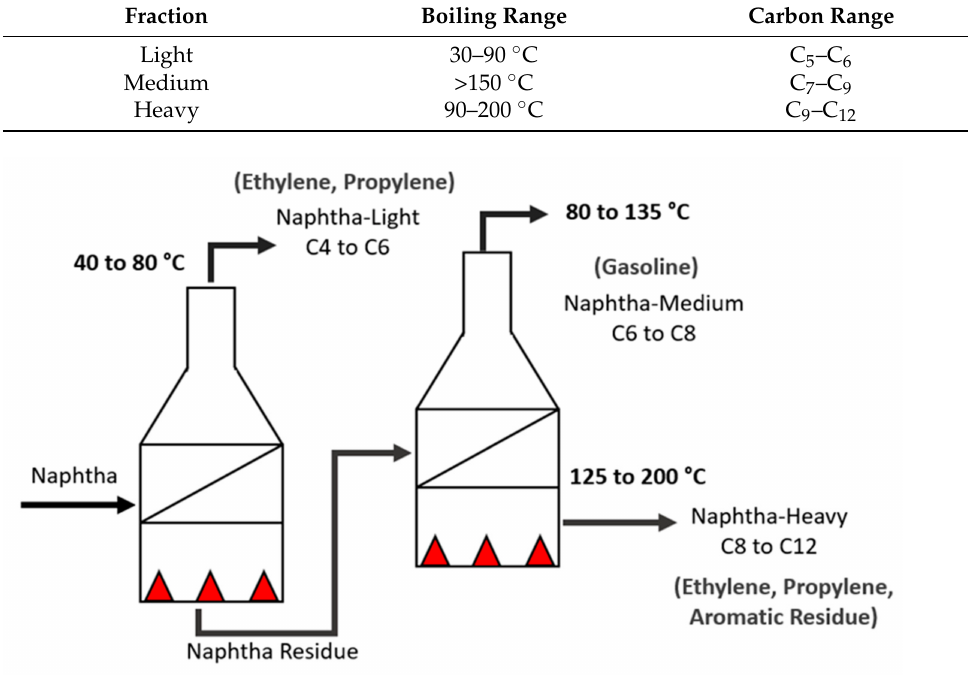
Figure 2. Naphtha cracking—pyrolysis